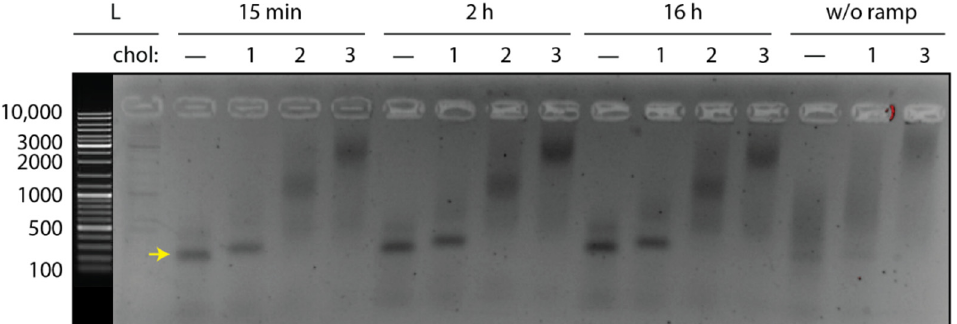
Figure 1. Characterization of amphiphilic 6-helix DNA nanotubes. Agarose gel analysis of DNA nanotubes self-assembled at different annealing times with varying numbers of cholesterol (from 0 to 3 cholesterol per nanotube). L, molecular weight marker (base pair length).